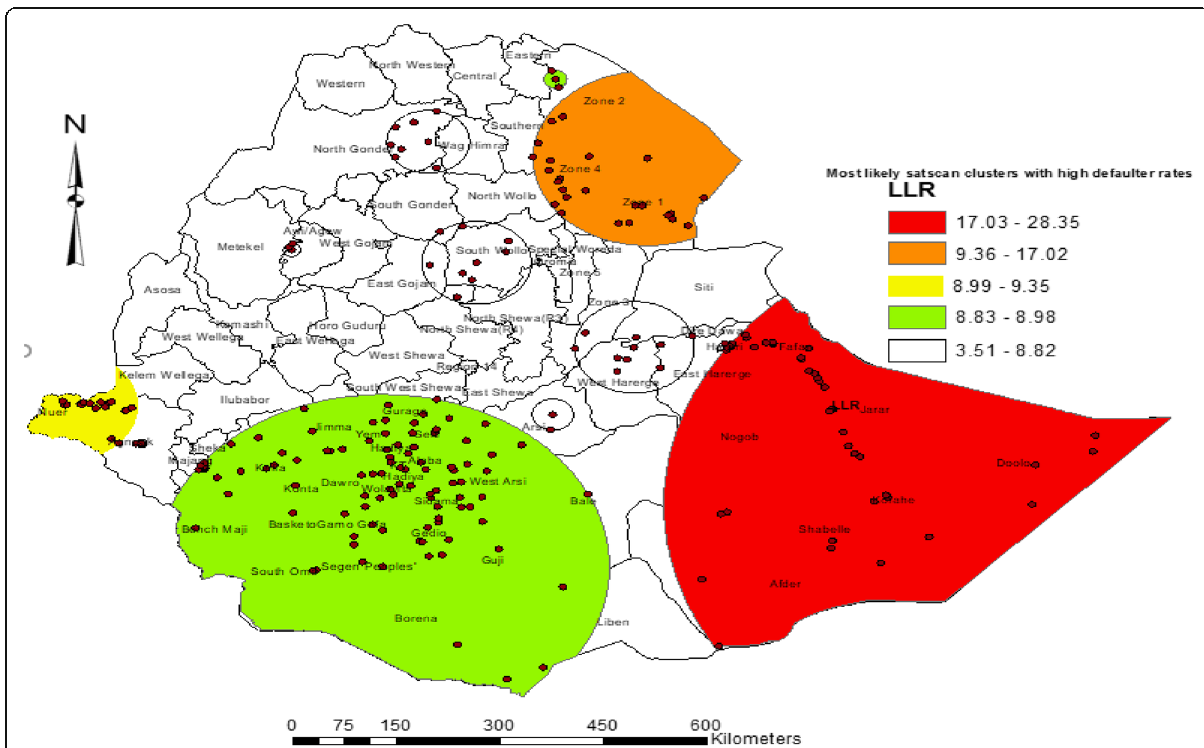
Fig. 6 Spatial clustering of areas with defaulting from immunization among children aged from 12 to 23 months in EDHS 2016